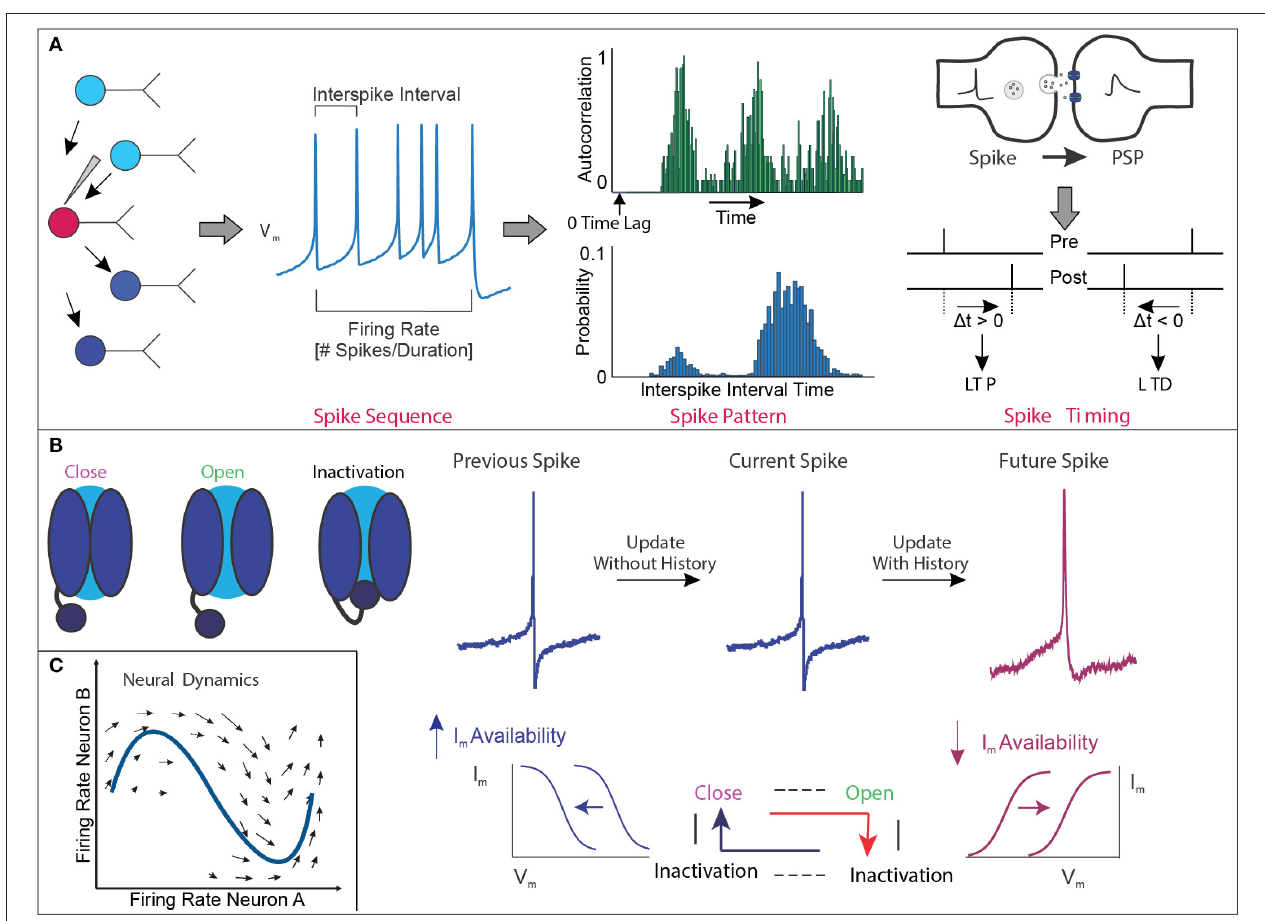
FIGURE 1 | Membrane potential dynamics. (A) Conceptual example of the quantification of membrane potential (Vm) dynamics representing the widely accepted temporal structure of the action potential spike sequence obtained during electrophysiology recordings. These analyses include the mean frequency of spikes within a given amount of time, regularity of spiking based on the probability distribution of the interspike interval, and autocorrelation function of spike trains over time to assess patterned neural timescales, as well as relative timing between presynaptic spike and postsynaptic spike to generate LTP/LTD. Note that the conceptual example focuses on the Vm of single cells and not a population of cells. (B) Conceptual example of hierarchical biophysical interactions between single channels and Vm state change to generate the hysteresis effect in time. In the presence of “perfect deactivation of inactivation” of voltage-gated ion channels following spike generation, availability of net ionic currents (Im) is increased, making set point shifting of Im–Vm relation (shown in blue). In this situation, there is no update of history in the next spike generation event, and thus each spike generation event is independent. In the presence of “imperfect deactivation of inactivation,” availability of Im is decreased, making set point shifting of Im–Vm relation (shown in magenta). Decreased availability of Im makes “updated history” in the next spike generation event, and thus, the next spike generation event is significantly influenced by the previous event. These sequential chains shape hysteresis effect to generate the higher-order temporal structure of spike trains. (C) Conceptual example of neural activity in the activity space. As the firing frequency of the two neurons changes, the neural activity moves in this two-dimensional space. If we observe the activity of n neurons at the same time, the activity pattern can be described in an n -dimensional activity